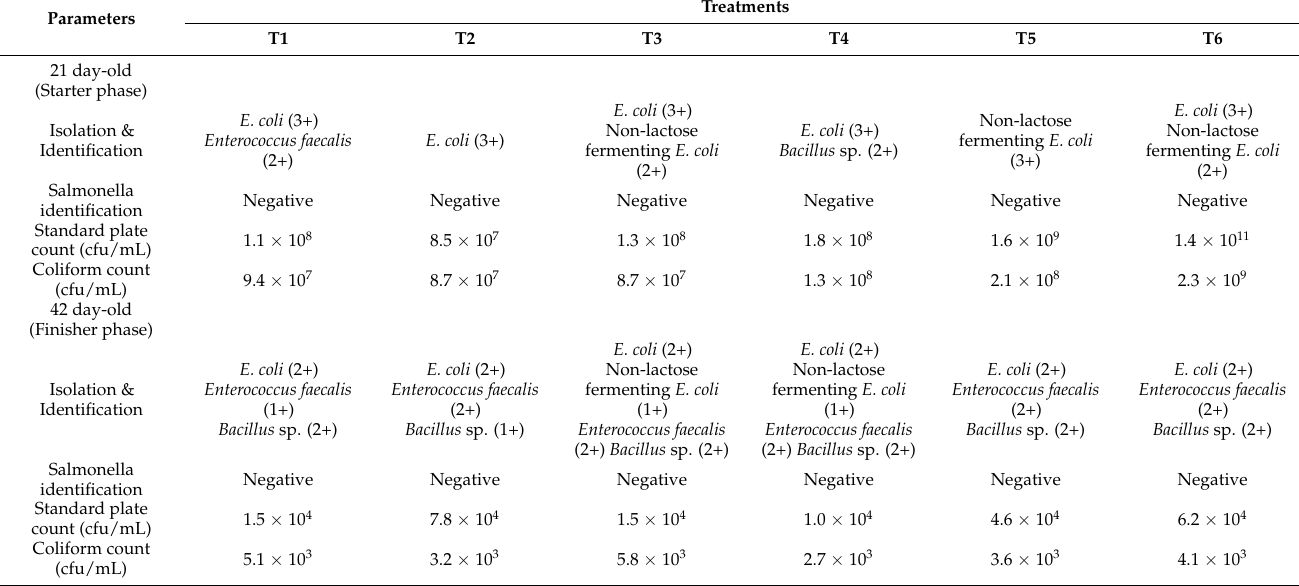
Table 5. Effect of Y. schidigera supplementation on the cecal micro-organisms of broilers on day 21 and